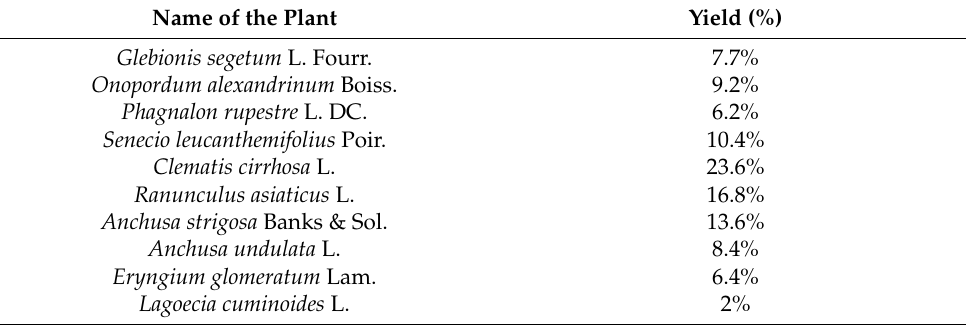
Table 3. Percentage Yield of the screened ethanol extracts. Name of the